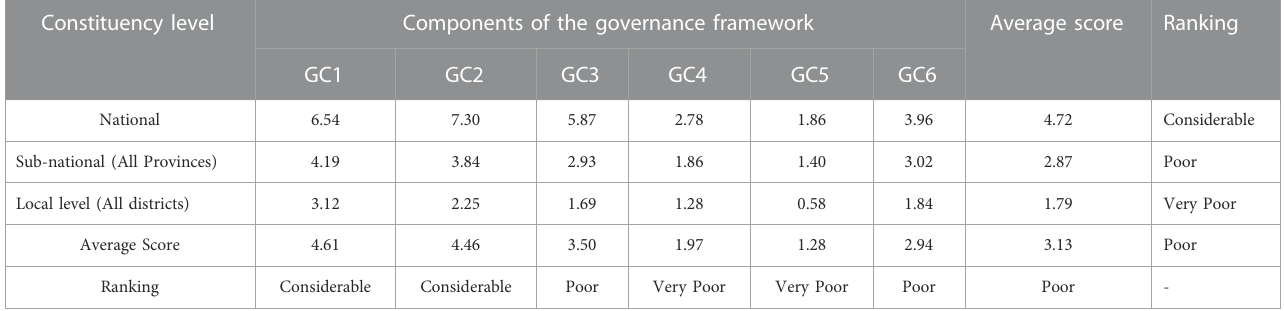
TABLE 3 Overall water sector index of governance for CCD.